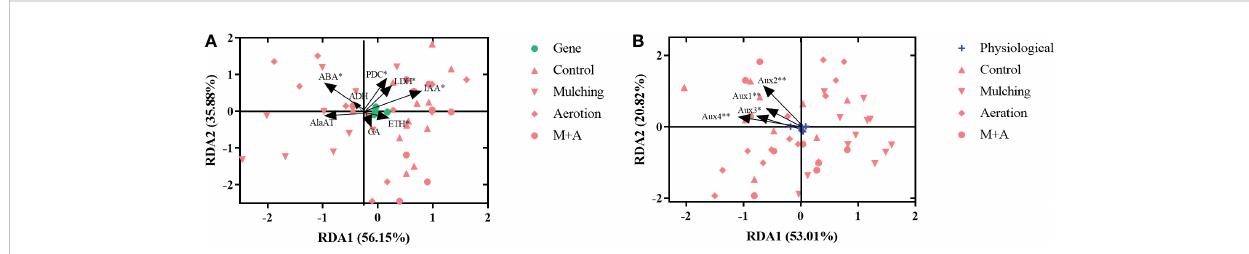
FIGURE 8 Redundancy analysis results reveal the correlations between physiological (A) and gene (B) factors in roots under mulching and aeration conditions. PDC: pyruvate decarboxylase; AlaAT: alanine aminotransferase; LDH: lactate dehydrogenase; ADH: alcohol dehydrogenase; IAA: indole-3-acetic acid; ETH: ethylene; ABA: abscisic acid; GA: gibberellic acid and Aux1 , 2 , 3 , 4 : auxin-related genes 1, 2, 3 and 4,